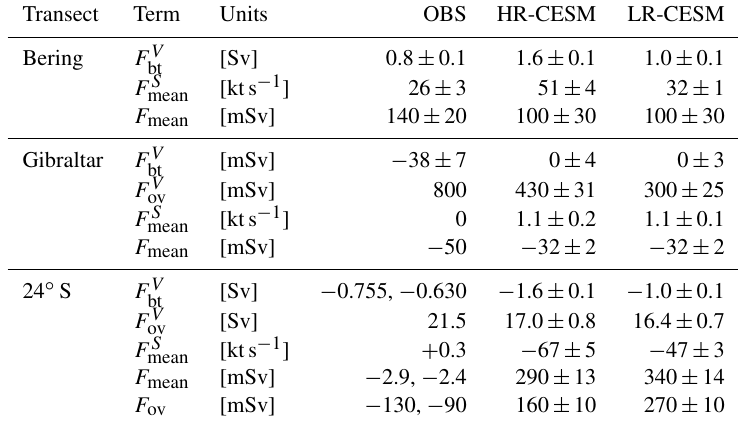
Table 2. Transport into the Atlantic of seawater, salt, and freshwater through the Bering Strait (Woodgate and Aagaard, 2005), the Strait of Gibraltar (Sánchez-Román et al., 2009), and across 24 ◦ S (Bryden et al., 2011). The barotropic seawater volume transport F V three transects and the overturning volume transport F V ov is given for the Strait of Gibraltar and at 24 ◦ S. The mean salt transport F S mean across a section is defined as the integrated product of monthly salinity and velocity fields (the unit [kts − 1 ] is equivalent to the also commonly used [Svpsu]). The mean freshwater transport F mean is defined similarly with the reference salinity S 0 = 35. The freshwater transport overturning component F ov is given only at 24 ◦ S. The ± denotes uncertainties in the observations and interannual standard deviations in the simulations. The two values for the observations at 24 ◦ S are estimates from two separate